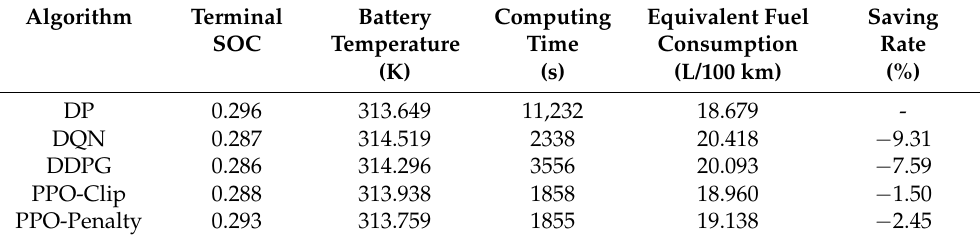
Table 8. The simulation results of fuel consumption in 4 × WVUSUB.